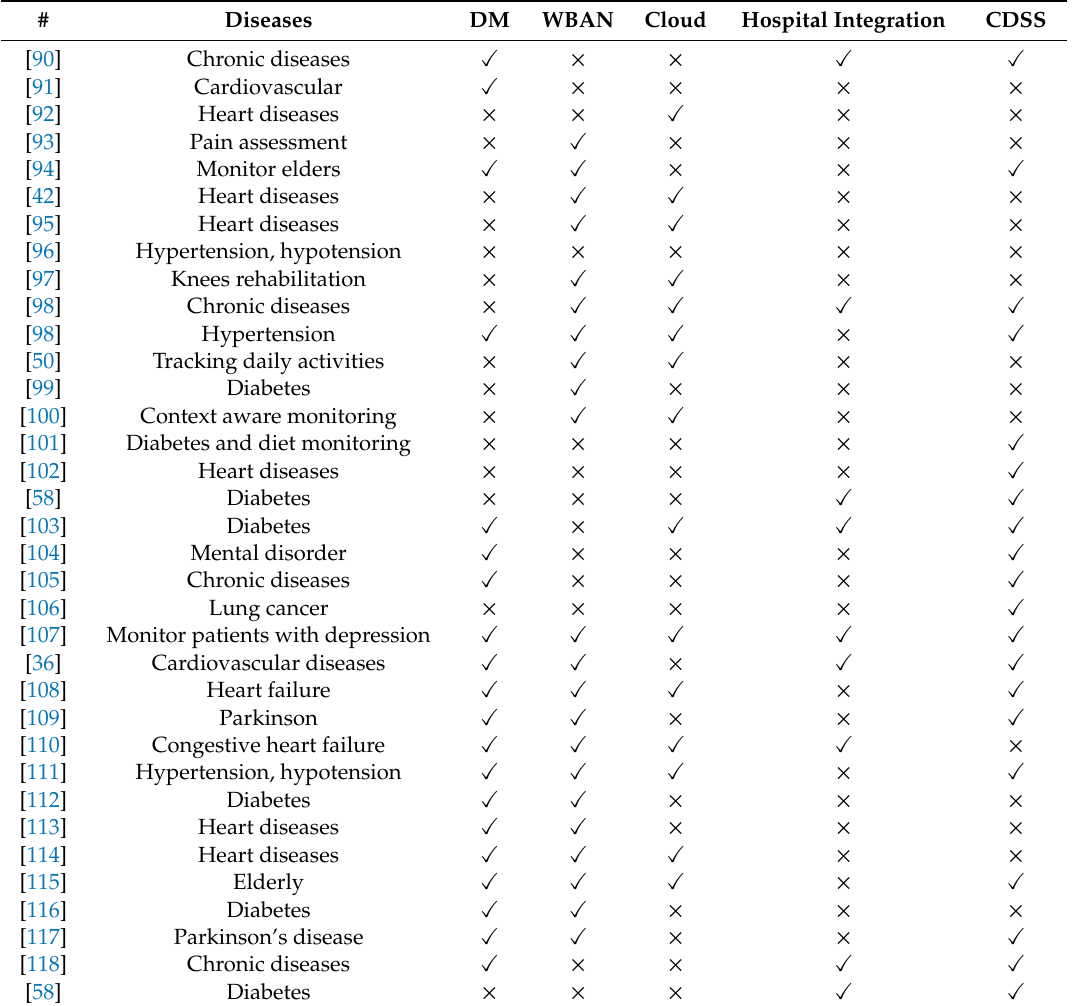
Table A1. Summarization of patient-monitoring